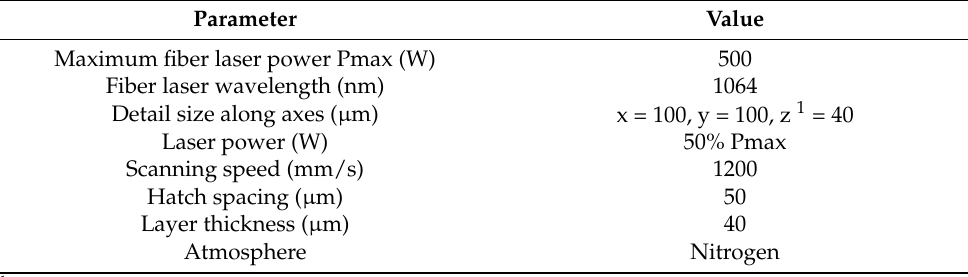
Table 1. Main characteristics of the manufacturing system and printing conditions.